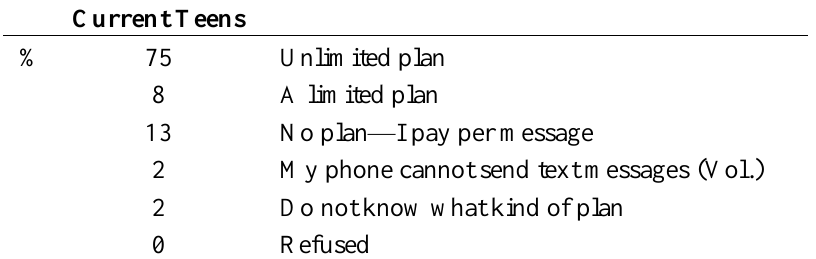
Table A8. What about the text messaging plan on your cell phone, if any? Do you have an unlimited text messaging plan; OR a plan with limits on the number or kind of messages you can send and receive per month; OR do you not have a plan and have to pay per-message? (Based on teen cell users [ N = 625]).